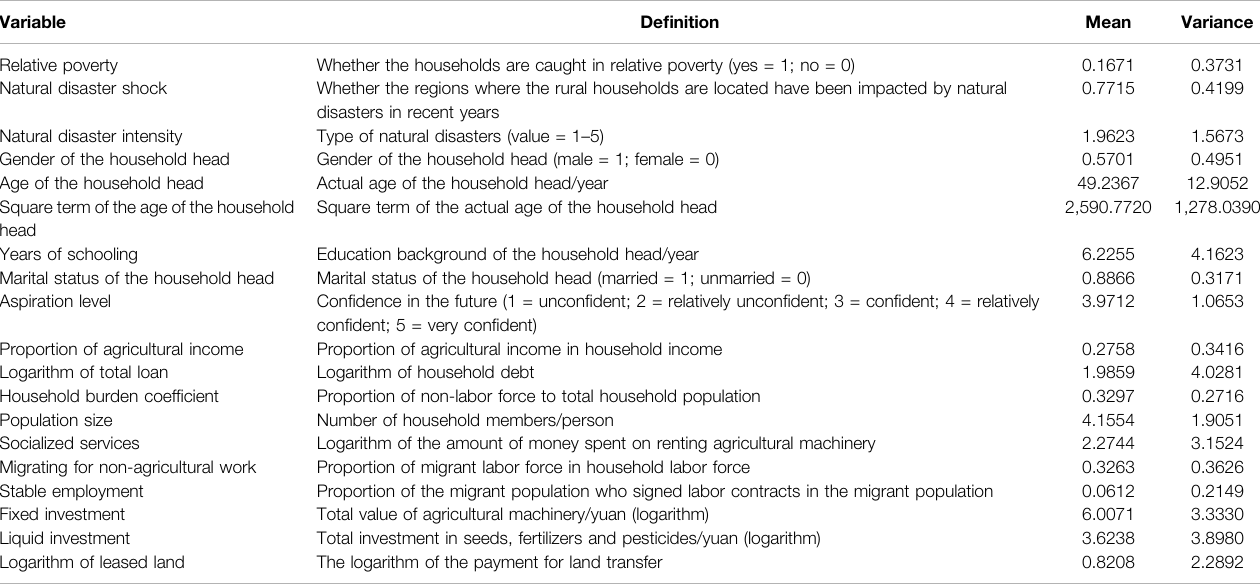
TABLE 1 | Descriptive statistics of control